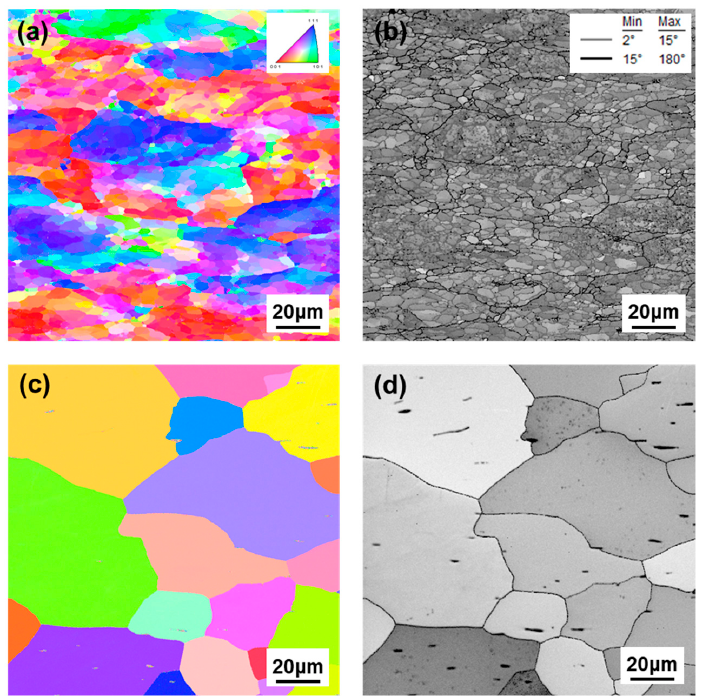
Figure 1. The inverse pole figure (IPF) and grain boundary misorientation maps (LAGBs (2° ≤ θ < 15°) and HAGBs ( θ ≥ 15°) are indicated by gray and black lines, respectively) of undeformed W samples; ( a ) and ( b ) DF-W, ( c ) and ( d ) RX-W.